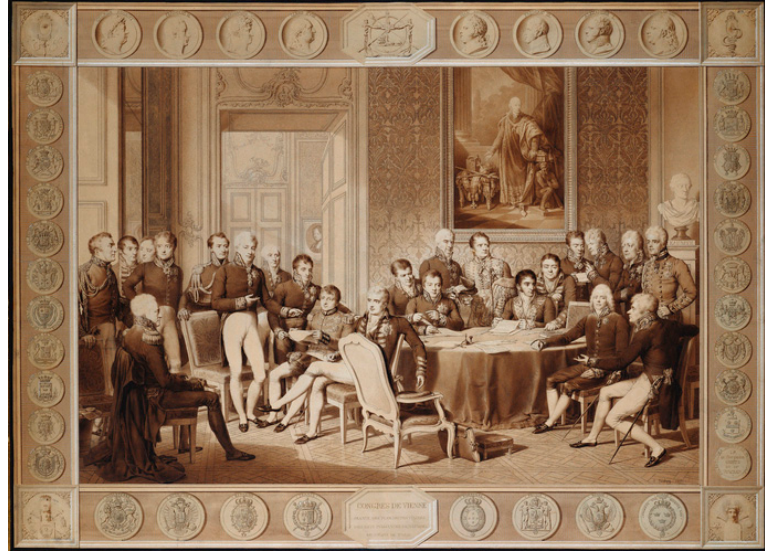
Figure 2. Jean-Baptiste Isabey. The Congress of Vienna. 1815. Pen and ink with wash. 84.5 cm × 107 cm. Royal Collection Trust/ © Her Majesty Queen Elizabeth II 2019. RCIN 451893.